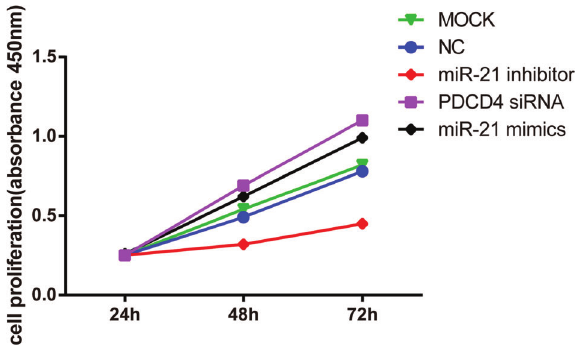
Figure 3. Growth curve of cells in each group after transfection (MOCK: blank control group; NC: negative control group; PDCD4: programmed cell death 4; miR-21: microRNA-21). Cell prolifera- tion was promoted in PDCD4 siRNA group and miR-21 mimics group; thus, the inhibition of microRNA-21 could remarkably suppress cell